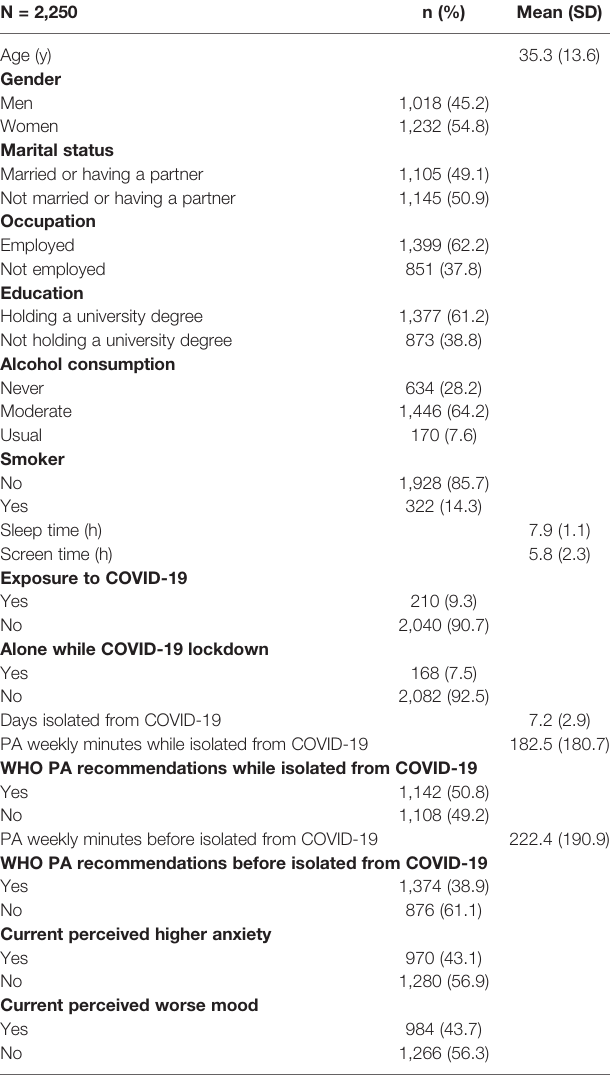
TABLE 1 | Characteristics of the study